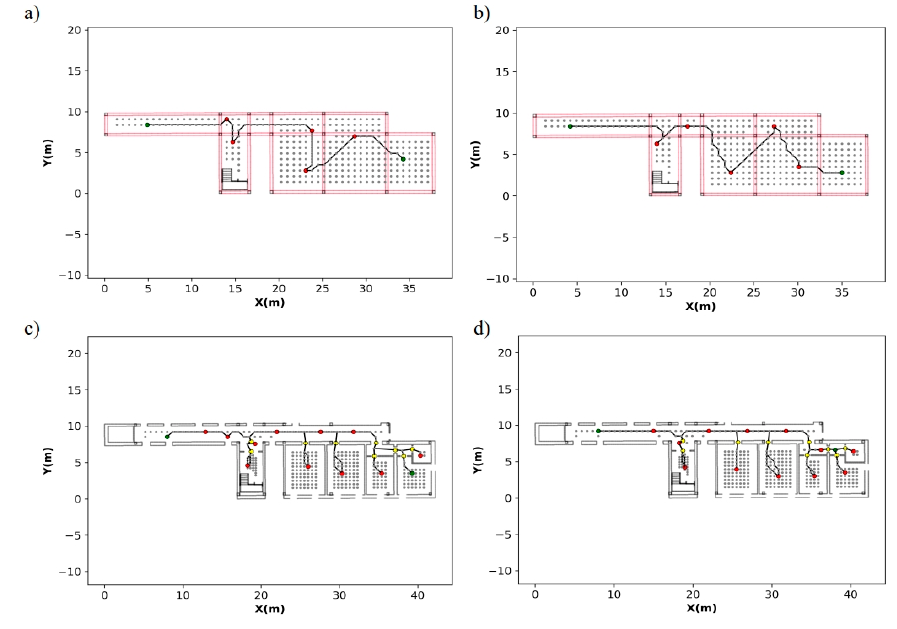
Figure 22. Optimal route calculated in case study 2.